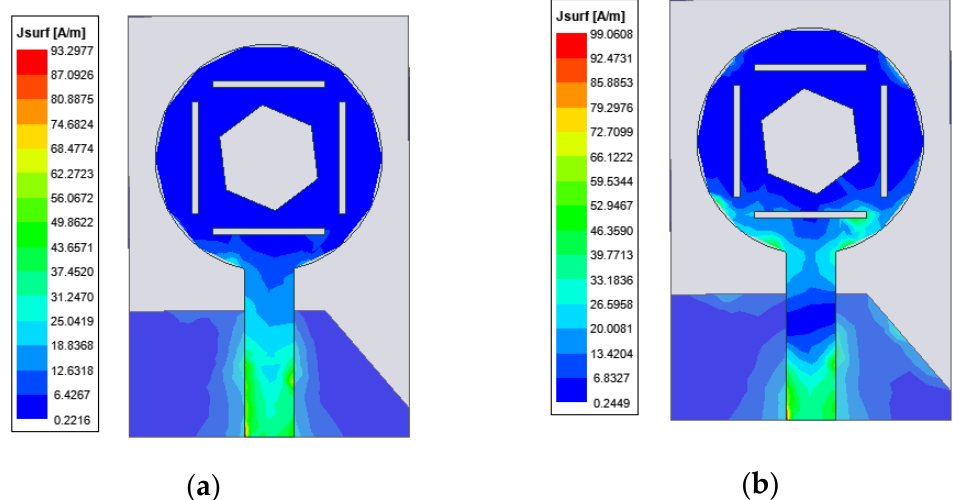
Figure 6. The current distribution of the UWB antenna with a phase of 0° at ( a ) 3.5 G and ( b ) 8.2 G.